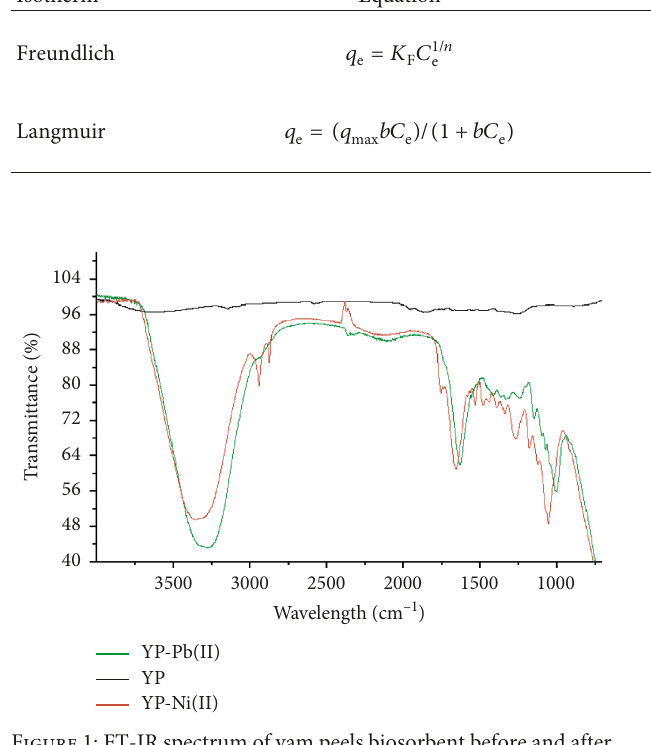
Figure 1: FT-IR spectrum of yam peels biosorbent before and after adsorption of nickel and